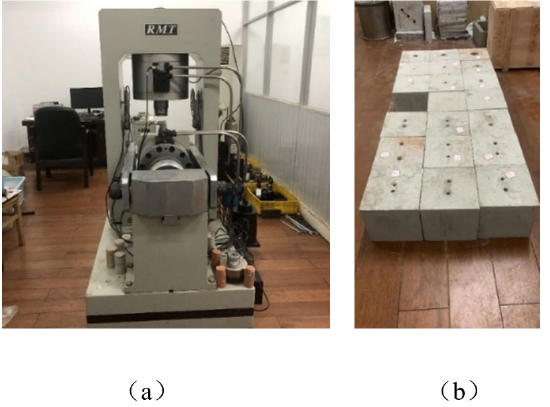
Figure 1. ( a ) is RMT ‐ 150 C rock mechanics servo testing machine; ( b ) is part of the test block. Table 1. Experimental design scheme table.